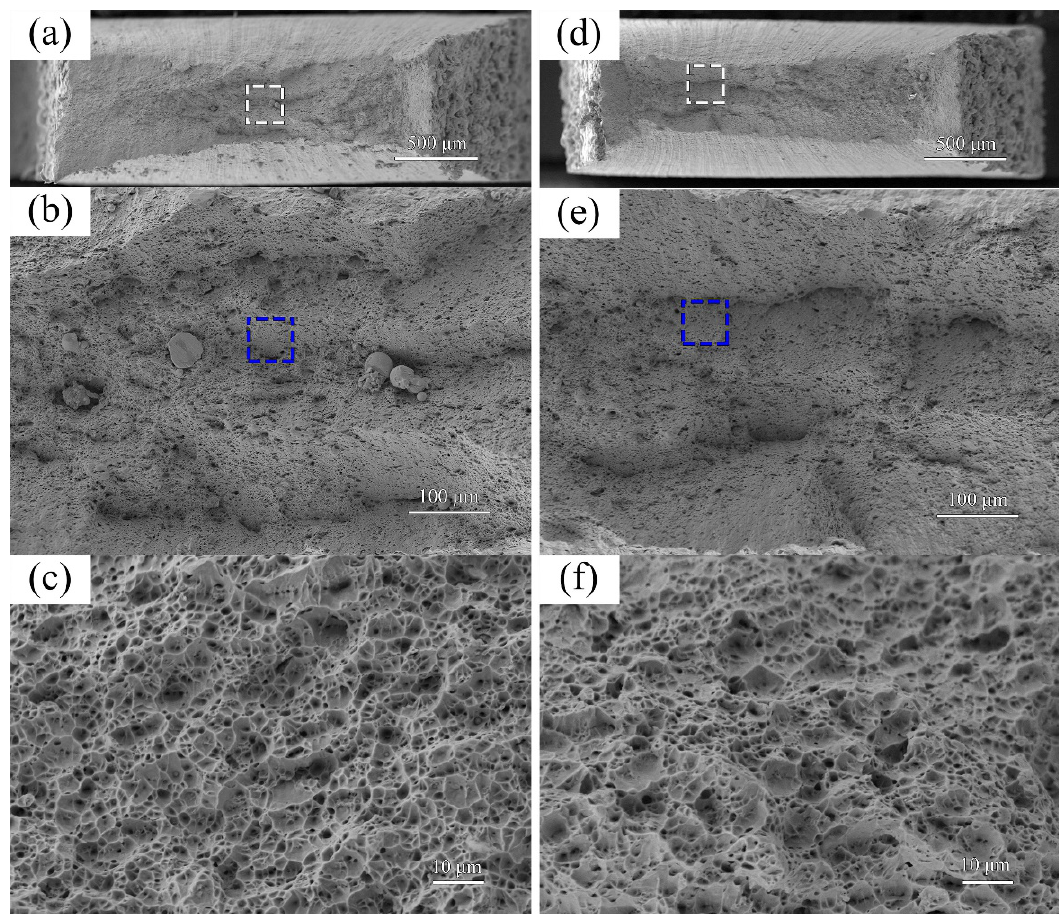
Figure 10. Fracture morphology with 20% reduction ratio: ( a ) macrostructure of sample 4; ( b ) mi- crostructure of white square in Figure 10a; ( c ) microstructure of blue square in Figure 10b; ( d ) macrostructure of sample 6; ( e ) microstructure of white square in Figure 10d; and ( f ) microstruc- ture of blue square in Figure 10d.